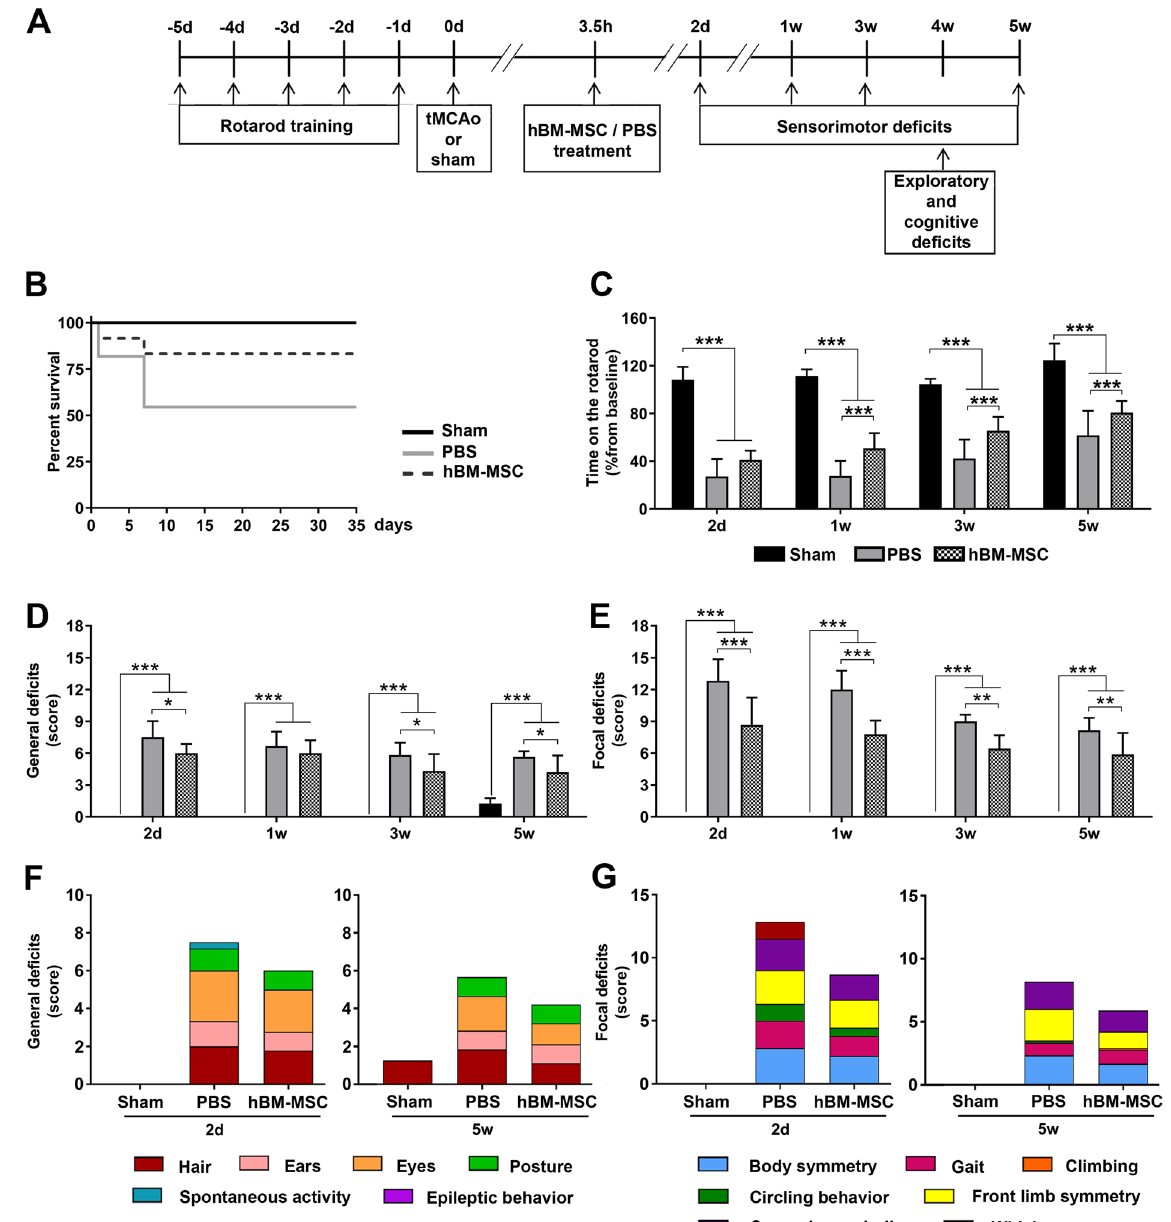
Figure 2. hBM-MSC treatment reduces sensorimotor deficits in stroke mice. ( A ) Experimental design. Initially mice were trained on the accelerated rotarod daily from − 5d to − 1d to generate stable baseline values. hBM- MSC were injected intravenously (IV) 3.5 h after tMCAo. Sensorimotor deficits were assessed at 2d, 1w, 3w and 5w. Exploratory and cognitive functions were evaluated at 4w measured by the open field and the novel object recognition (NOR) tests. Mice were sacrificed 5w after tMCAo. ( B ) Survivals in sham, tMCAo hBM- MSC and tMCAo PBS mice are shown by Kaplan-Meier curves. ( C ) Latency to fall off the rod was similarly reduced at 2d in both groups of stroke mice. hBM-MSC treatment induced a progressive improvement in the rotarod performance that was significant superior to that of tMCAo PBS mice. ( D , E ) The neuroscore revealed an increase in general ( D ) and focal ( E ) deficits in stroke mice as compared to sham. tMCAo hBM-MSC mice showed better general and focal scores compared to tMCAo PBS mice already at 2d, and this difference persisted throughout the observation period. The contribution of each individual parameter on general ( F ) and focal deficits ( G ) in tMCAo hBM-MSC and tMCAo PBS mice for the earliest (2d) and latest (5w) evaluation is shown. Data are mean + SD, n = 6–10, ( B ) Log-rank (Mantel-Cox) test p = 0.06. ( C ) Two-way ANOVA for RM p treatment < 0.0001, p time < 0.0001, p interaction < 0.0001; ( D ) Two-way ANOVA for RM p treatment < 0.0001, p time < 0.0001, p interaction < 0.0001. ( E ) Two-way ANOVA for RM p treatment < 0.0001, p time < 0.0001, p interaction < 0.0001. Tukey’s post-hoc test: * p < 0.05, ** p < 0.01, *** p <